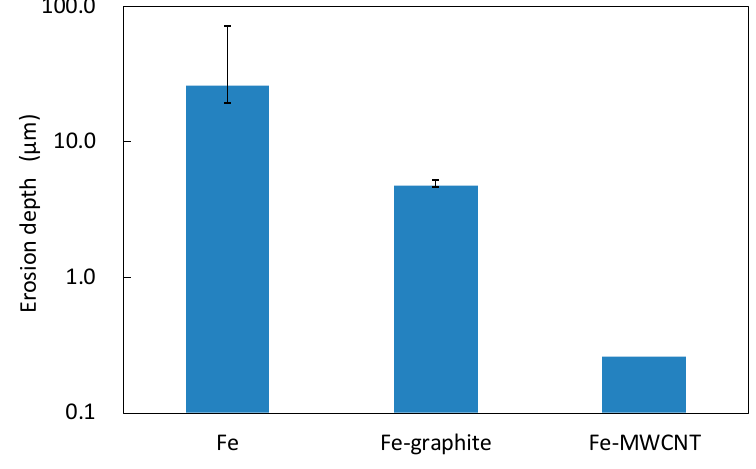
Figure 9. Results of erosion-resistance test at 623 K.